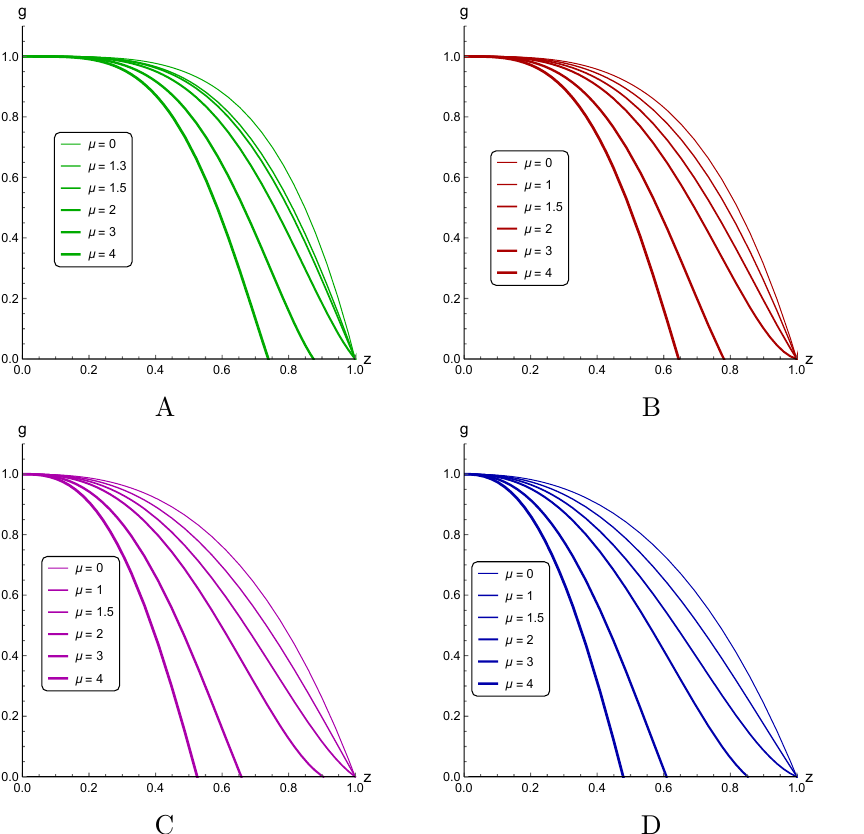
Figure 3 . Blackening function g ( z ) for different µ in isotropic (A) and anisotropic cases for ν = 1 . 5 (B), ν = 3 (C), ν = 4 . 5 (D); a = 4 . 046 , b = 0 . 01613 , c = 0 . 227 , z h = 1